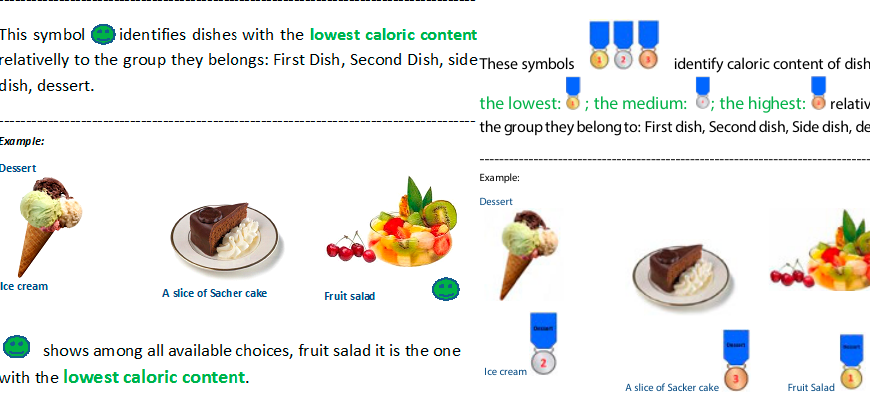
Figure 1. Explanation of LCL (left panel) and CRL (right